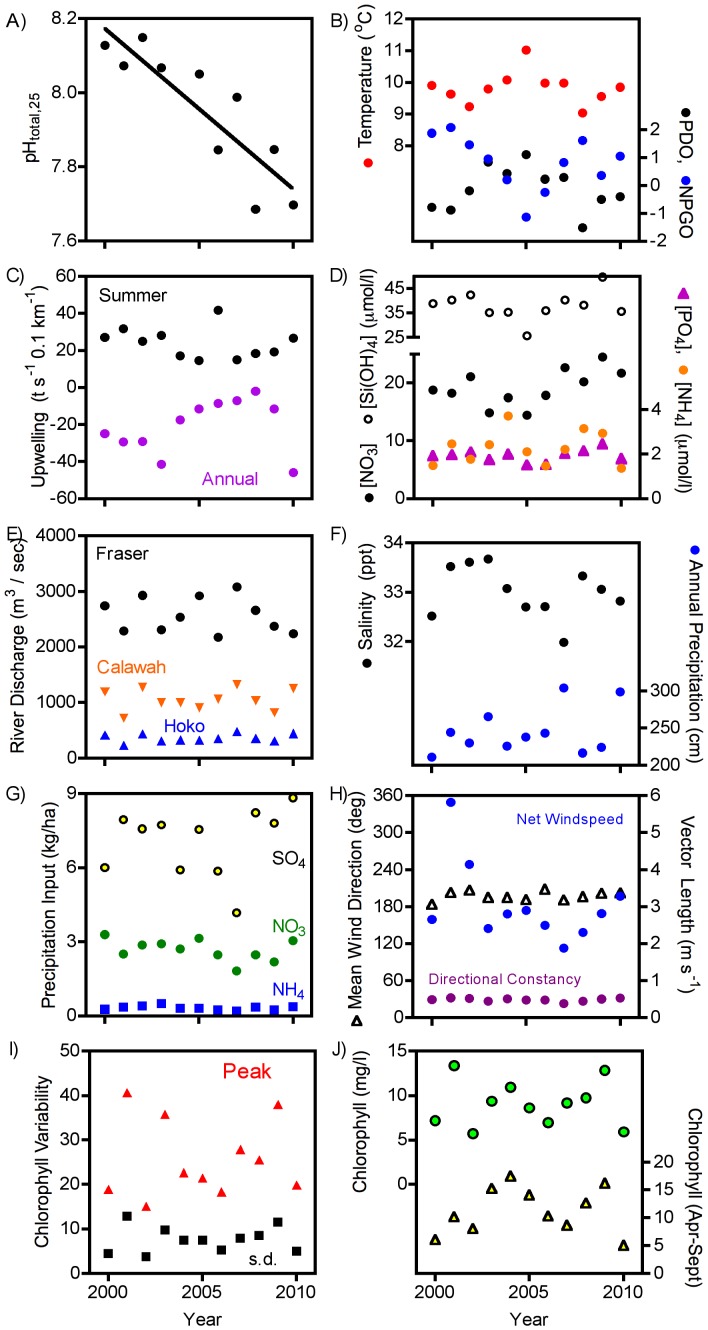
Temporal trends in annual means of pH and potential environmental drivers of pH.A) pH, B) Temperature, PDO and NPGO, C) Upwelling (summer average only, annual average), D) Nutrients (PO4, Si(OH)4, NO3, NH4), E) Discharge from three rivers, F) Salinity and precipitation, G) Precipitation chemistry, H) Local winds (mean direction, average wind speed and relative constancy), I) Phytoplankton chlorophyll variability (peak value, standard deviation), J) Average phytoplankton chlorophyll (summer only and average annual). Significant (p<0.05) regressions indicated with curves.